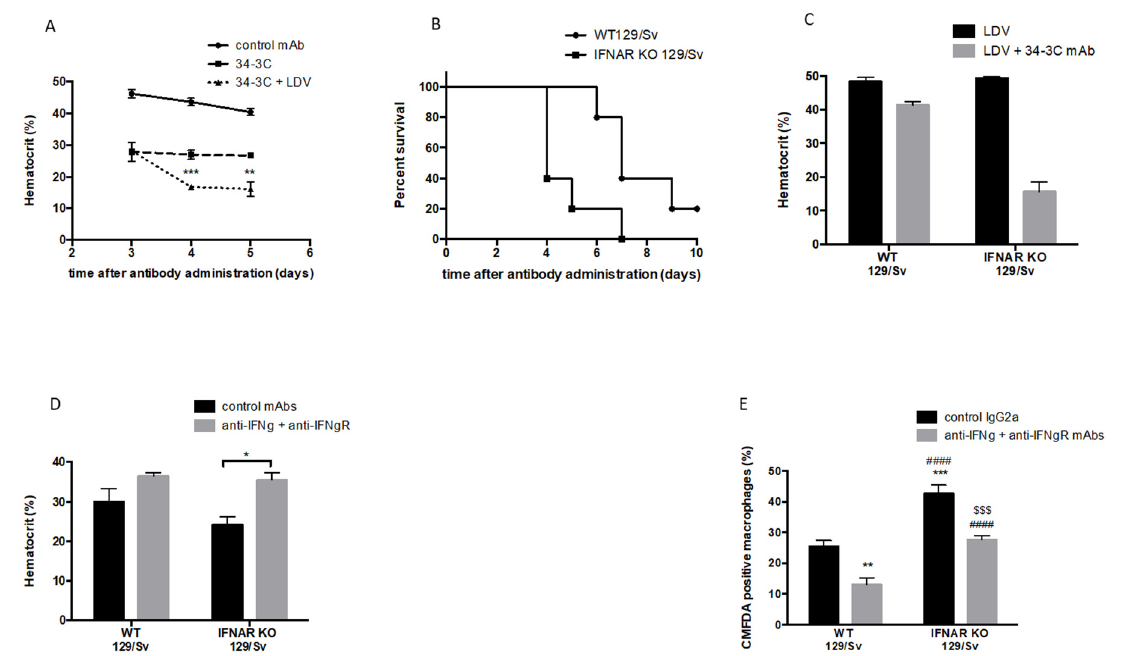
Figure 1. Role of type I and type II IFNs in anemia and ex vivo erythrophagocytosis in LDV-infected mice. ( A ) Hematocrits in groups of 6 to 8 C57BL/6 mice pooled from 2 independent experiments at different times after administration of 50 μ g 34-3C IgG2a mAb or A6202F4M control mAb. LDV infection occurred one day before mAb administration. ( B ) Survival of 10 129/Sv or IFNAR KO-infected mice after administration of 350 μ g 34-3C anti-RBC mAb. ( C ) Hematocrit in groups of WT 129/Sv or IFNAR KO mice challenged with 50 μ g of 34-3C IgG2a mAb or A6202F4M control mAb. Hematocrit were measured 4 days after LDV infection. ( D ) Hematocrits after administration of 50 μ g 34-3C IgG2a mAb to groups of 4 129/Sv or IFNAR KO-infected mice treated with or without IFN- γ and IFN- γ R-blocking antibodies (300 μ g one day before LDV infection, 1 mg 3 h after infection, followed by a dose of 1 mg every 2 days). ( E ) Ex vivo erythrophagocytosis of 34-3C-opsonized RBCs by macrophages of 9 to 11 129/Sv or IFNAR KO-infected mice pooled from 2 independent experiments and treated with or without IFN- γ and IFN- γ R-blocking antibodies (300 μ g one day before LDV infection, 500 μ g 3 h after infection). * p <0.05, ** p<0.01, *** p<0.001, * compared to infected 129/Sv; $$$ compared to anti-IFN γ -treated infected 129/Sv; #### compared to IFNAR KO. The results are shown as the means ± SEM